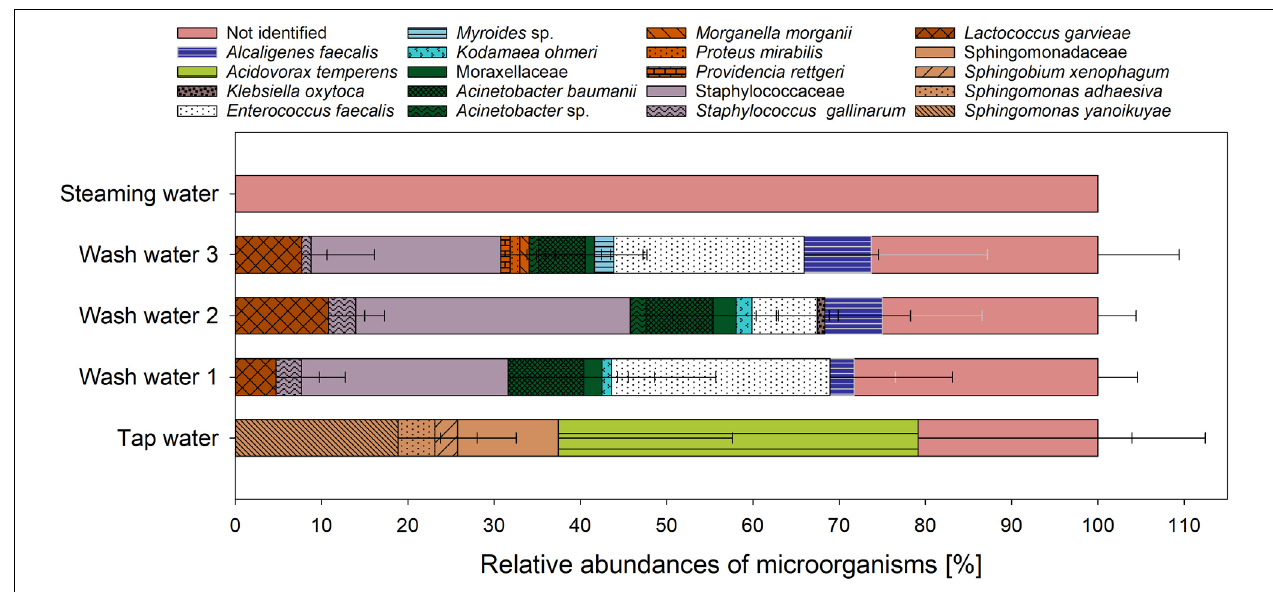
and biochemical characterization which is very time